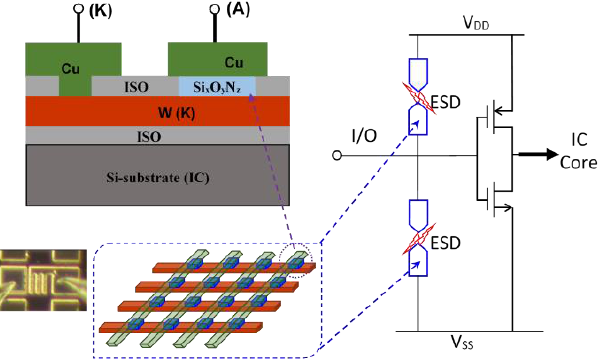
Figure 25. Concept of above-IC nano-crossbar array ESD protection.